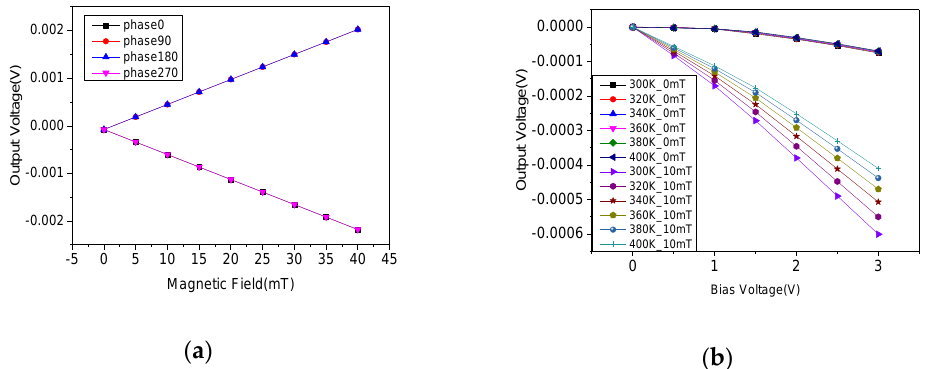
Figure 12. ( a ) Effect of magnetic induction on device; ( b ) Effect of temperature on device.